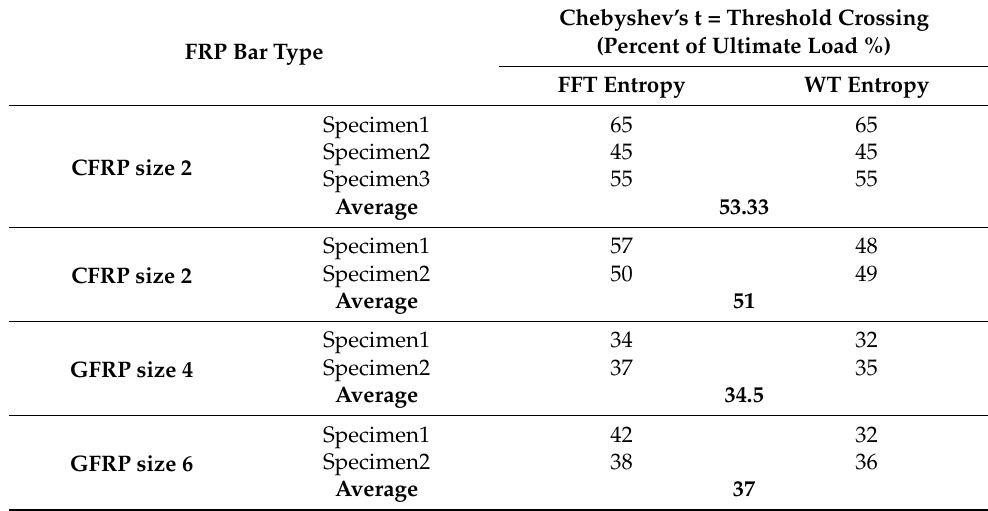
Table 3. List of the results of exceeding the Chebyshev’s threshold for all the FRP bar